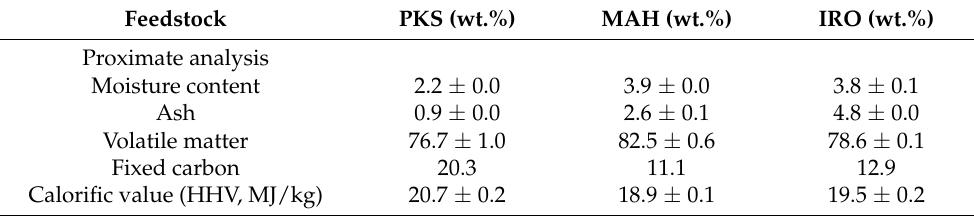
Table 2. Proximate analysis and characterisation of raw PKS, MAH and IRO.